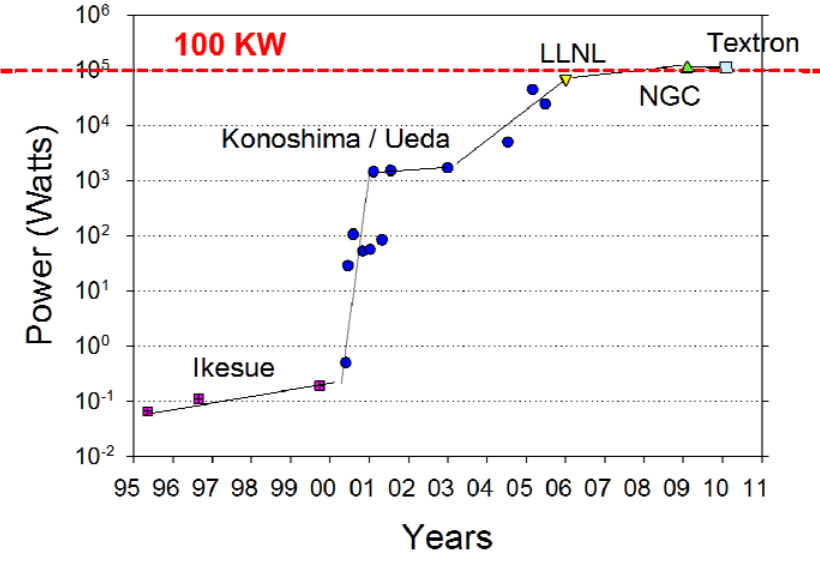
Figure 21. Evolution of laser output power versus year for YAG